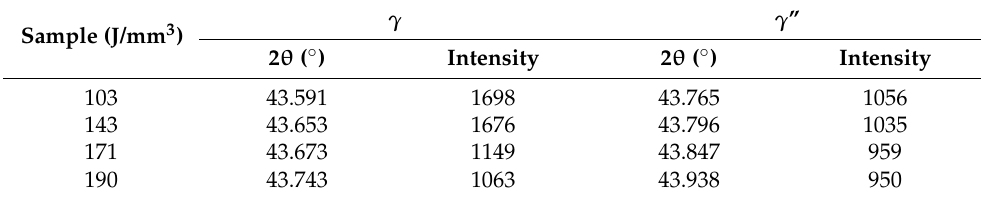
Figure 5. XRD patterns of SLM formed Inconel 718 parts under different laser energy densities obtained in a wide range of 2 θ = 20 ◦ –100 ◦ ( a ) and obtained in a small range of 2 θ = 42 ◦ − 45 ◦ ( b ). Table 3. XRD data of identified peaks for Inconel 718